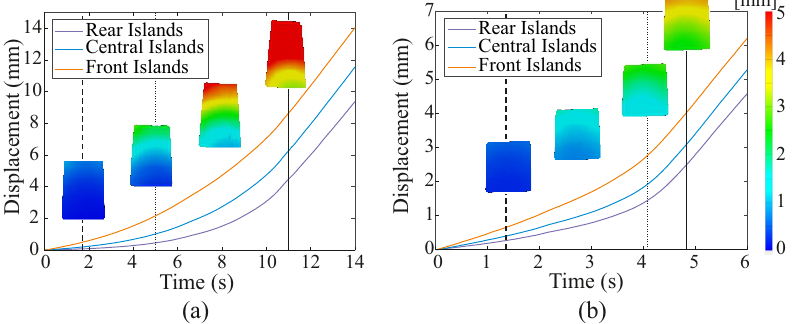
Figure 7. Typical results for average tissue displacement at the front, middle, and rear of the grasper face measured using DIC. The vertical dashed and dotted lines indicate that the time slip was first detected at the outer and middle islands, respectively, whereas the solid vertical line indicates the time of macro slip. The colour maps show the changes in the displacement profiles over time. ( a ) Mat A, 20 N, 2 mm/s. ( b ) Mat C, 20 N, 2 mm/s.